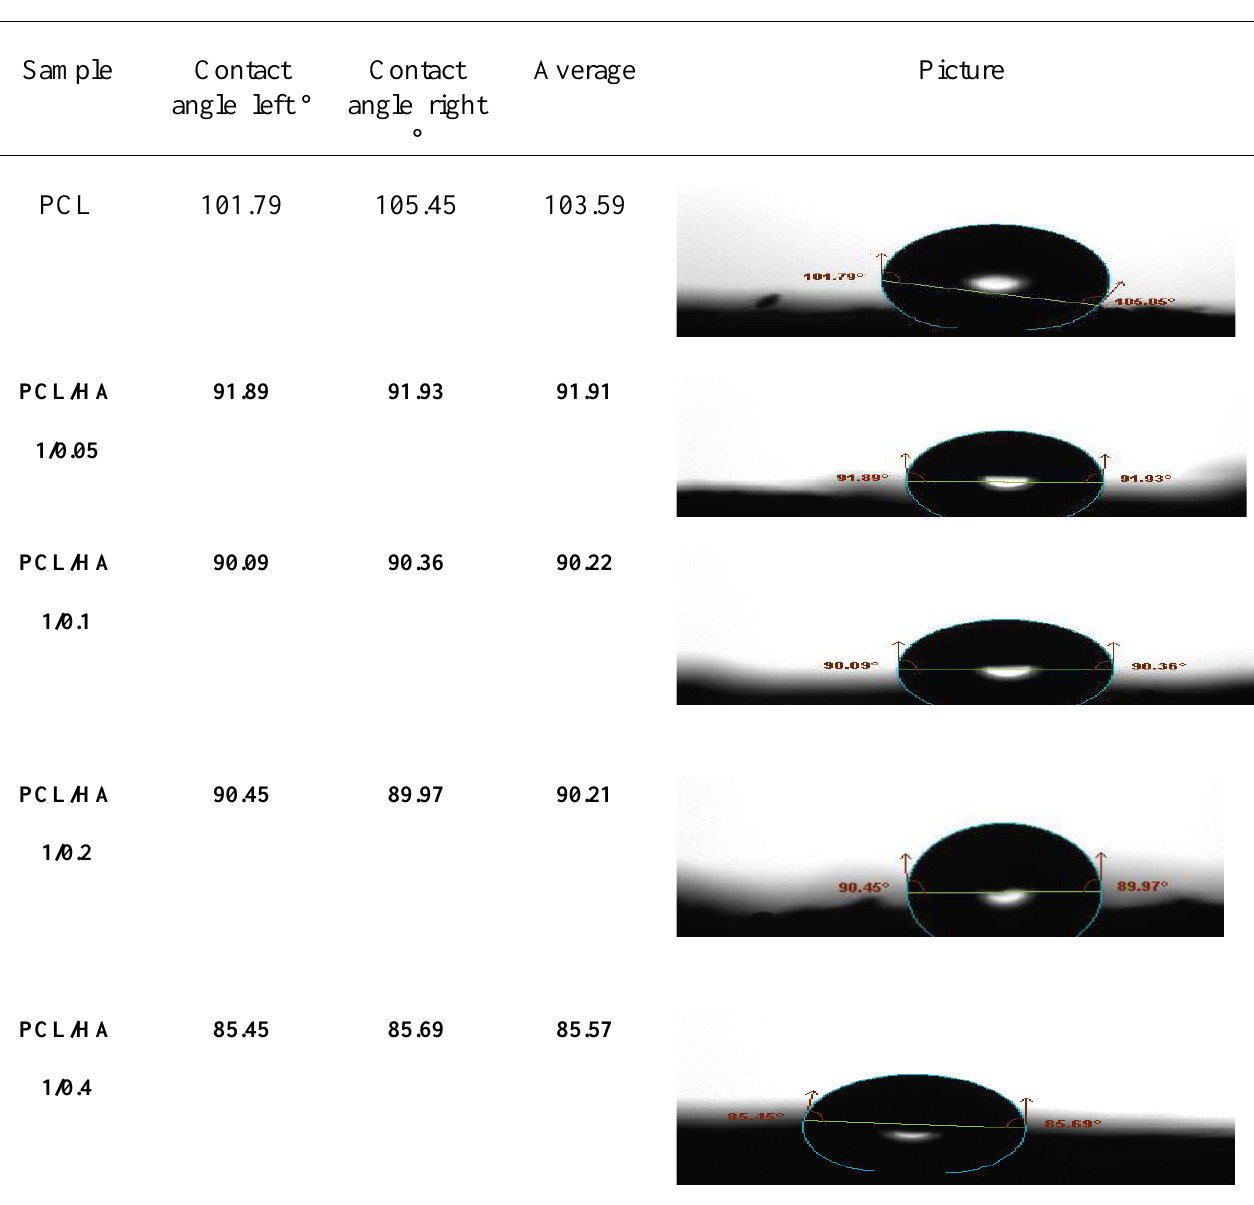
Table 2: Contact angles of PCL/HA